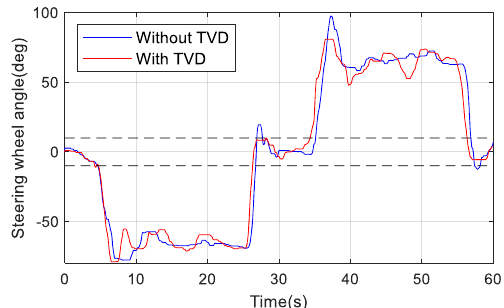
Figure 11. Curves of steering wheel angle.